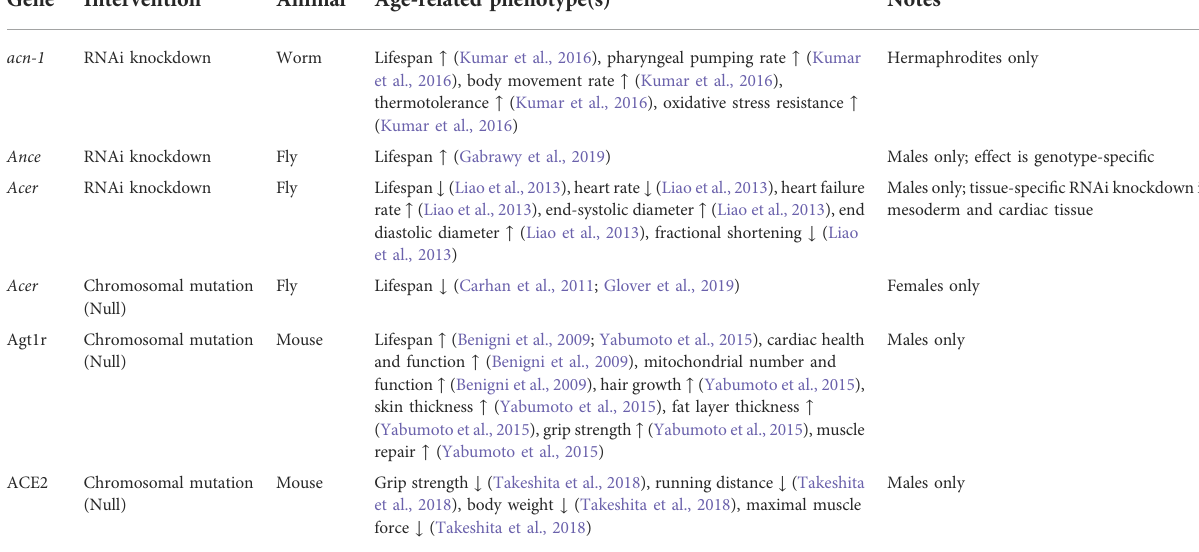
TABLE 2 Genetic interventions on the RAS system and effects on age-related